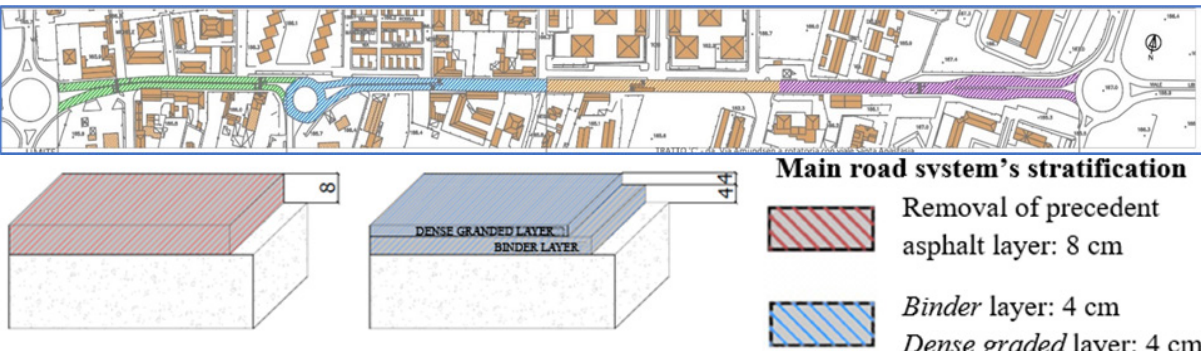
Figure 2: Detail of the design of low-noise pavement in Viale Libertà –